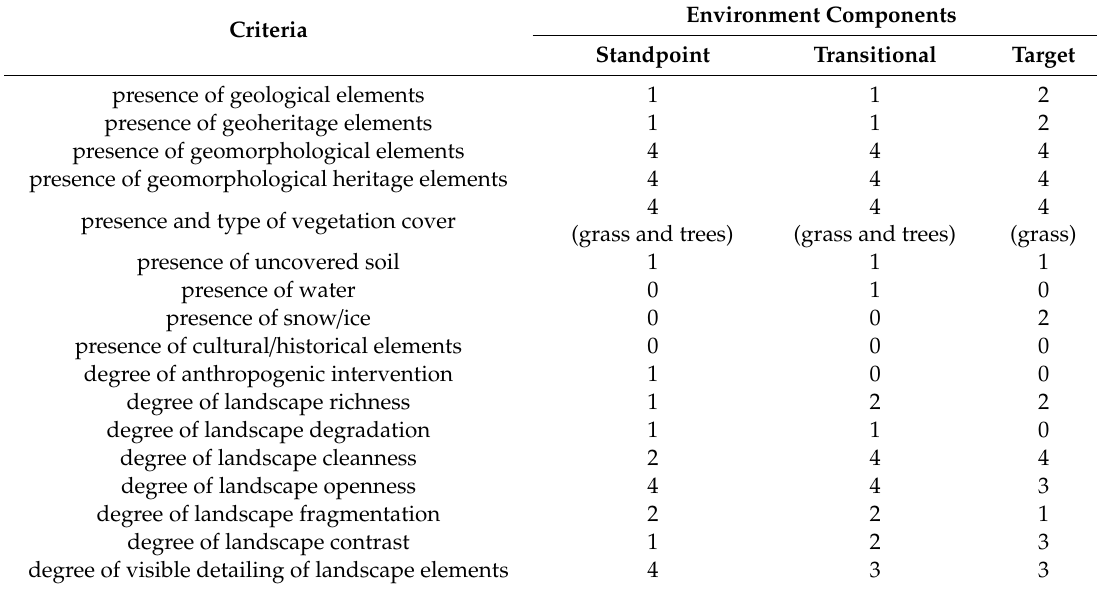
Table 3. Environment of the Nagai-Koshki